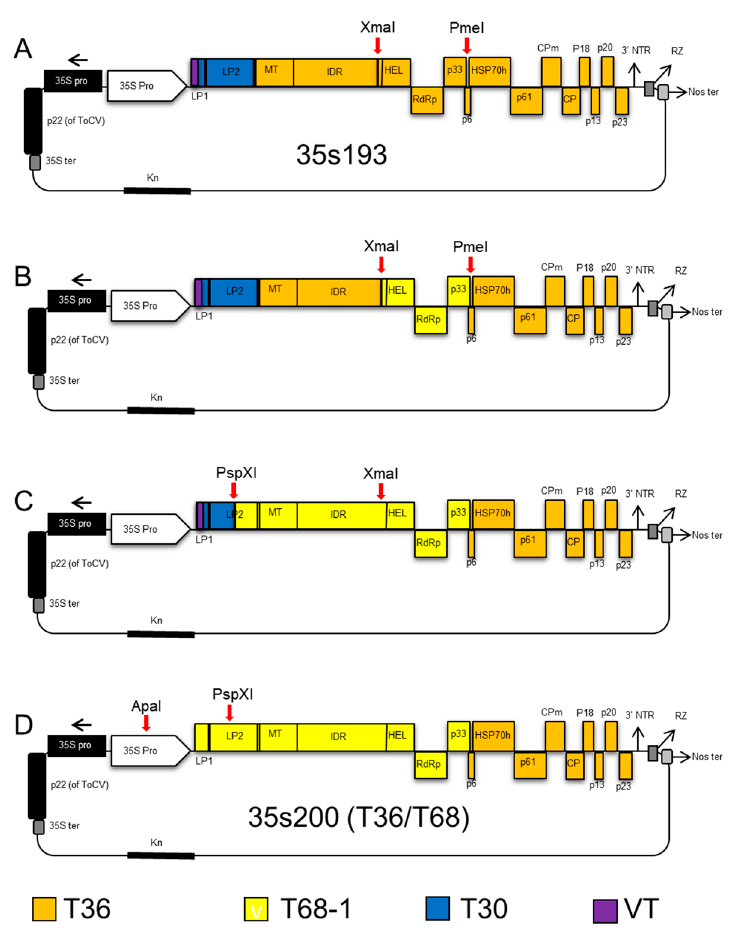
Figure 2. Schematic representation of cloning steps of the CTV T36-T68 (35s200) infectious hybrid clone. ( A ) The 35s193 plasmid vector of VT-T36 which was used as a backbone clone; ( B ) the fragment containing helicase, RdRP , and p33 was amplified from isolate T68-1 and ligated into the CTV-T36 infectious plasmid vector 35s193, which was digested with the same restriction enzymes (XmaI and PmeI); ( C ) the fragment between leader protease LP2 and helicase from T68-1 was amplified and ligated into the plasmid vector after digesting with PspXI and XmaI; and ( D ) the fragment flanking the ApaI restriction enzyme site at the 35s (CaMV) promoter and a PspXI restriction enzyme site at nucleotide 2068 was added to the plasmid vector to produce the new infectious hybrid clone named 35s200 used for studying the transmission of CTV.